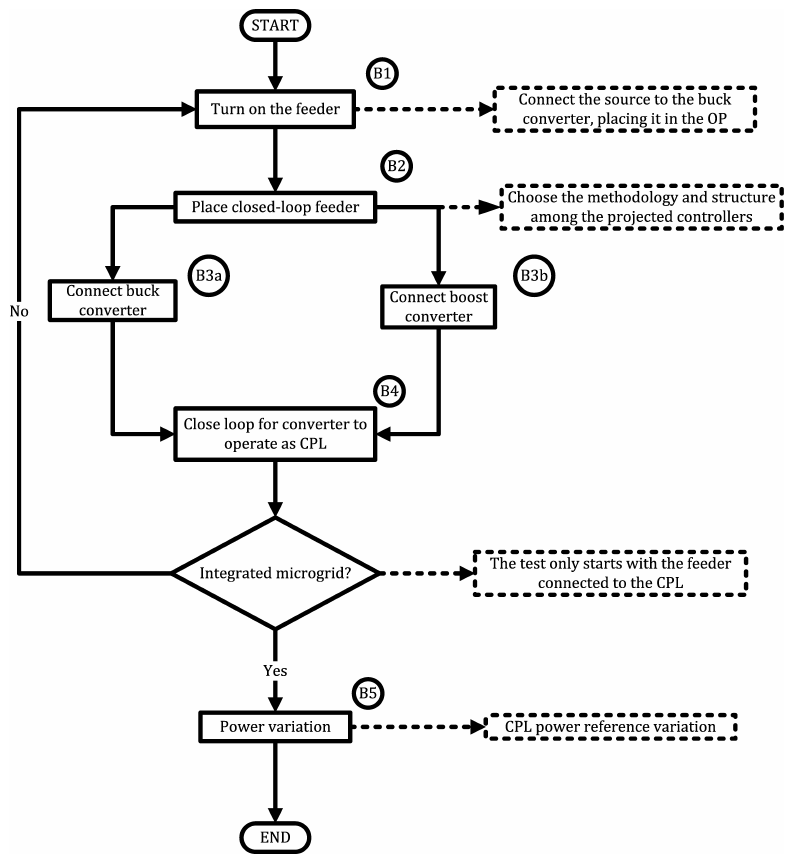
Figure 15. Flowchart of the experimental evaluation